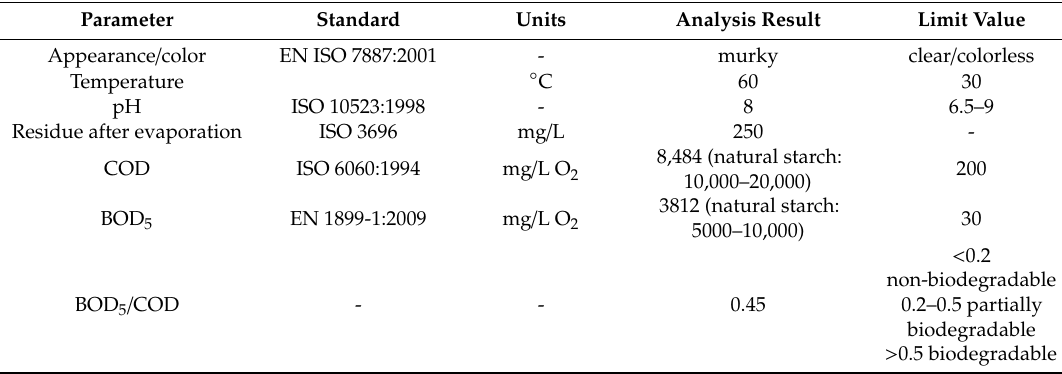
Table 9. Results of the water analysis after desizing and